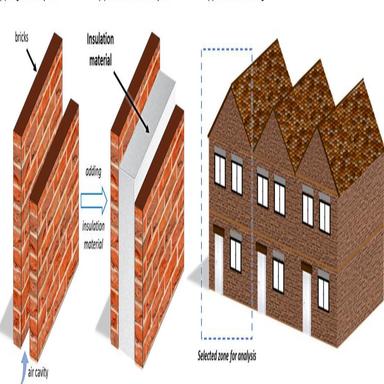
(a) Simulated masonry cavity wall without and (b) with insulation material, and (c) building model for simulation.